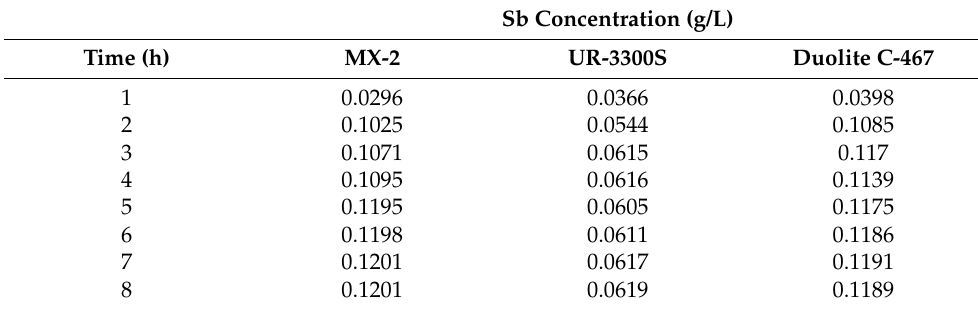
Table 13. Concentration of Sb (in g/L) in Chilean clean solutions that left the ion-exchange resins tested by Cifuentes et al.